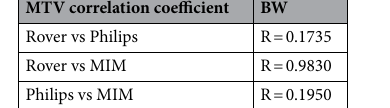
Table 4. Pearson correlation coefficient for MTV values.